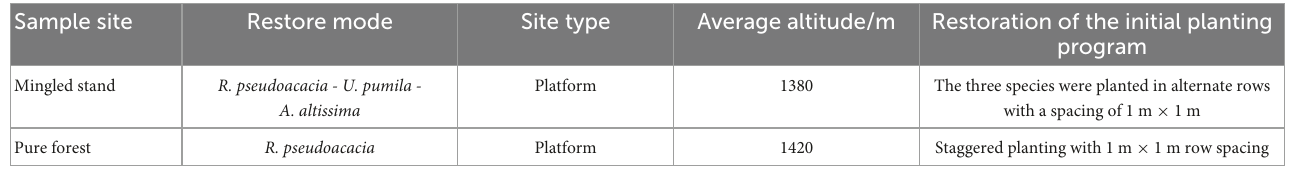
TABLE 1 Summary of restoration patterns by sample site.